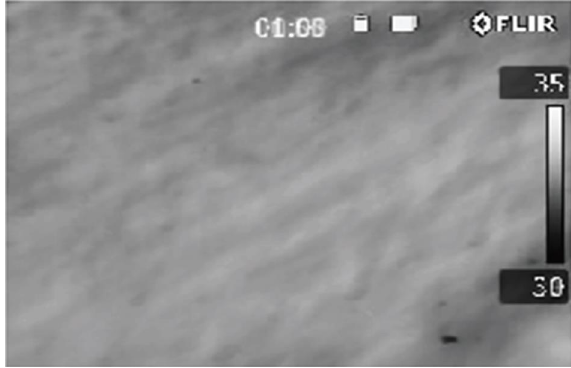
Figure 13: Sample of the extracted background